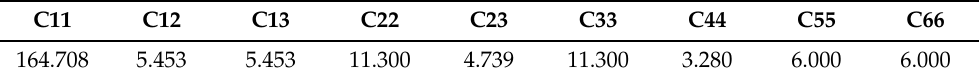
Table 3. Material properties of T800/924 laminate (elastic constants in GPa) [1].